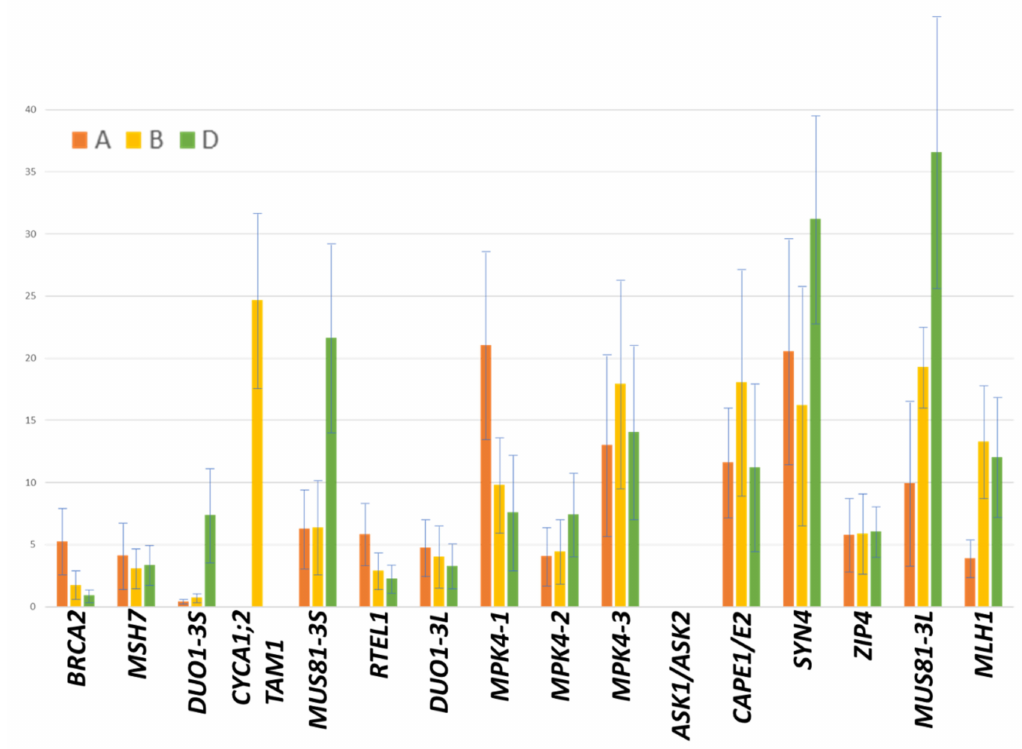
Figure 5. Level of expression (FPKM values; average of the four stages and two replicates) in meiotic tissues [55] of the different homoeologous copies ( A : orange; B : yellow; D : green) of genes known as being involved in recombination in model species and located on chromosome